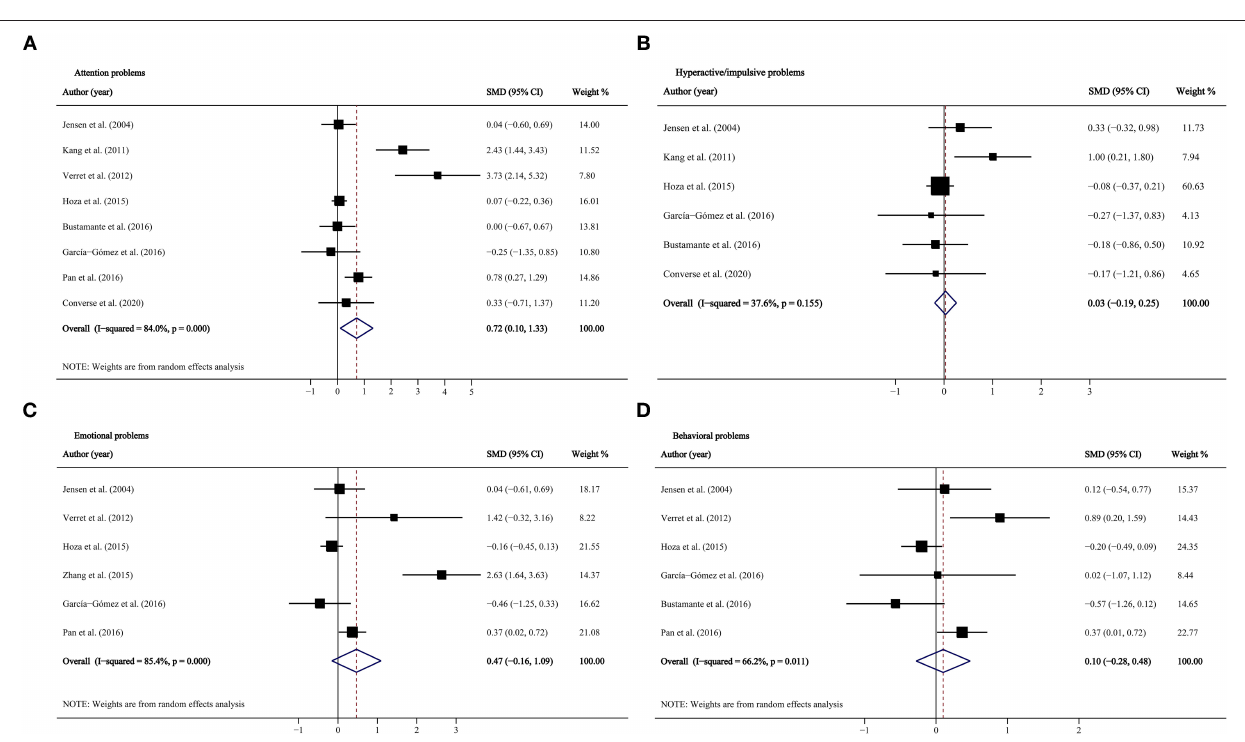
difference on hyperactive/impulsive, emotional, and